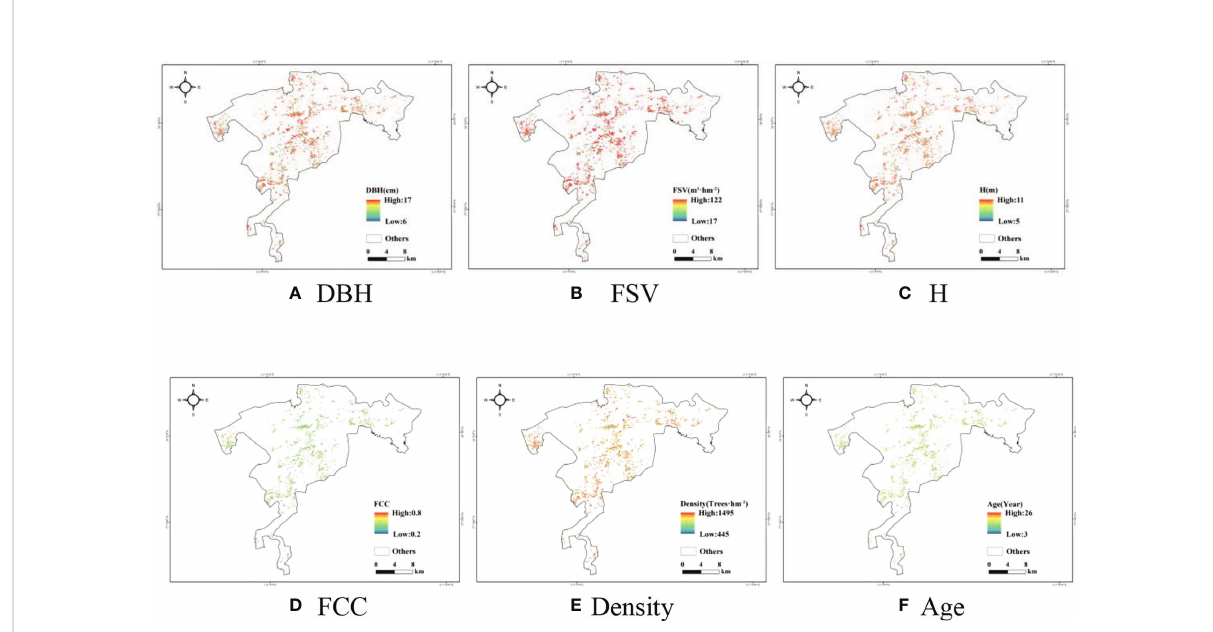
FIGURE 4 Maps of the forest parameters estimated by optimal models. (A) DBH (B) FSV (C) H (D) FCC (E) Density (F) Age.